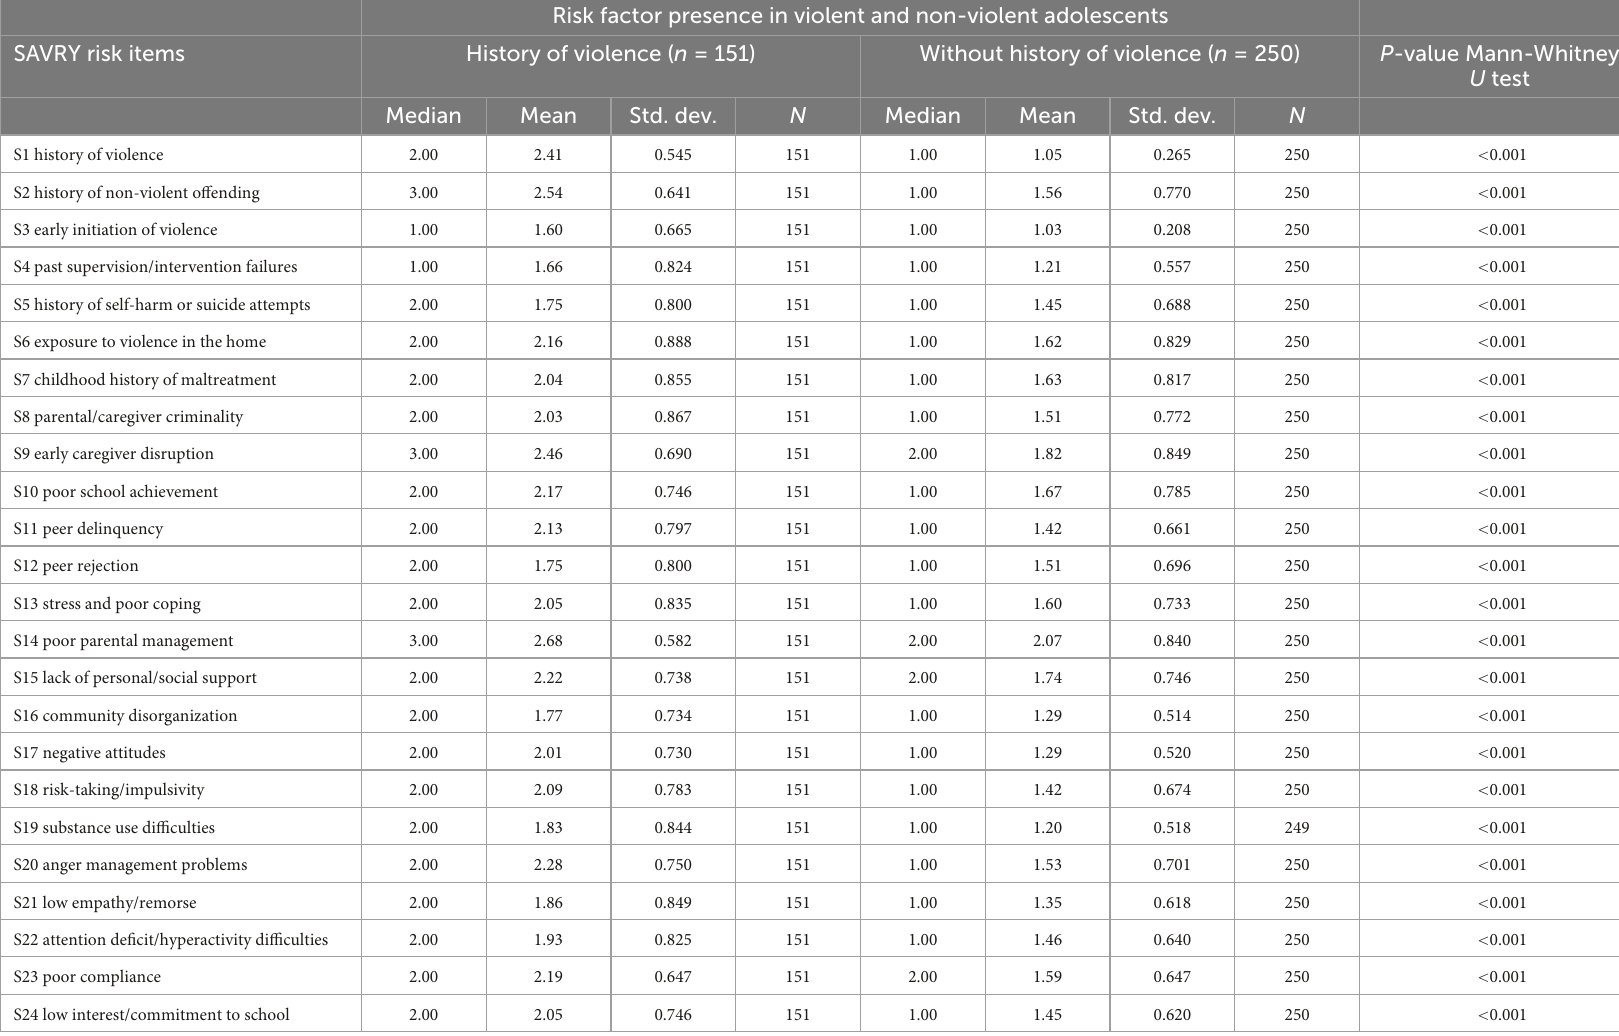
TABLE 2 Risk and protective prevalence due to Structured Assessment of Violence Risk in Youth (SAVRY) scale in violent and non-violent